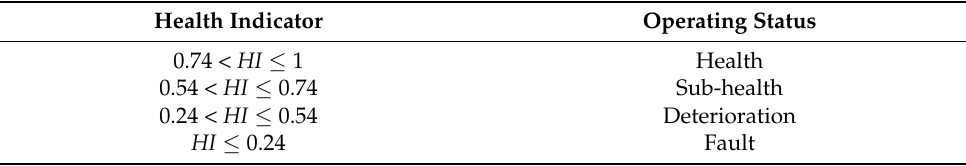
Table 7. Gear pump operating status division